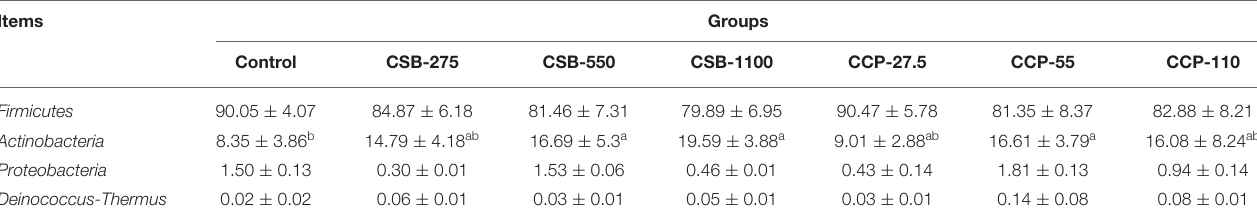
TABLE 4 | Abundance of main microbiota (accounting for ≥ 0.05% of the total sequences in at least one of the samples) in each group (abundance of the phyla is expressed as a percentage). Items